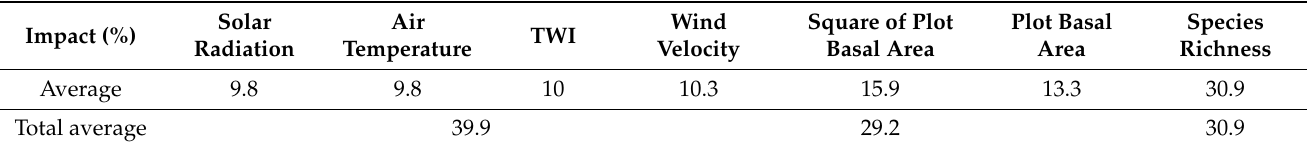
Table 7. Percent impact of individual and grouped variables (species richness and abiotic and biotic factors) on MLP-based calculations of productivity according to the sensitive